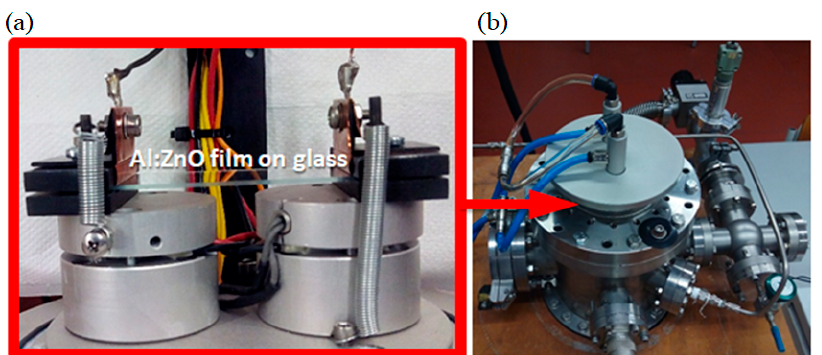
Figure 2. ( a ) Core of the homemade setup used for the measurement of the Seebeck coe ffi cient, consisting of two Peltier devices used for heating and cooling the edges of the samples deposited on glass slides. ( b ) Vacuum chamber, containing the Seebeck measurement setup.